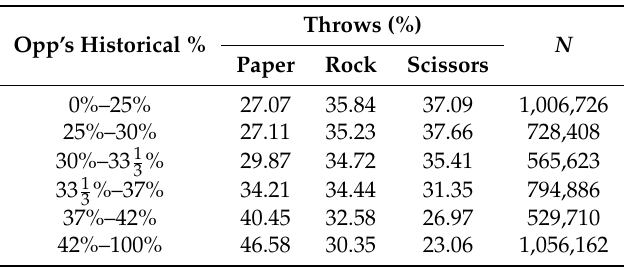
Table 2. Response to Percent